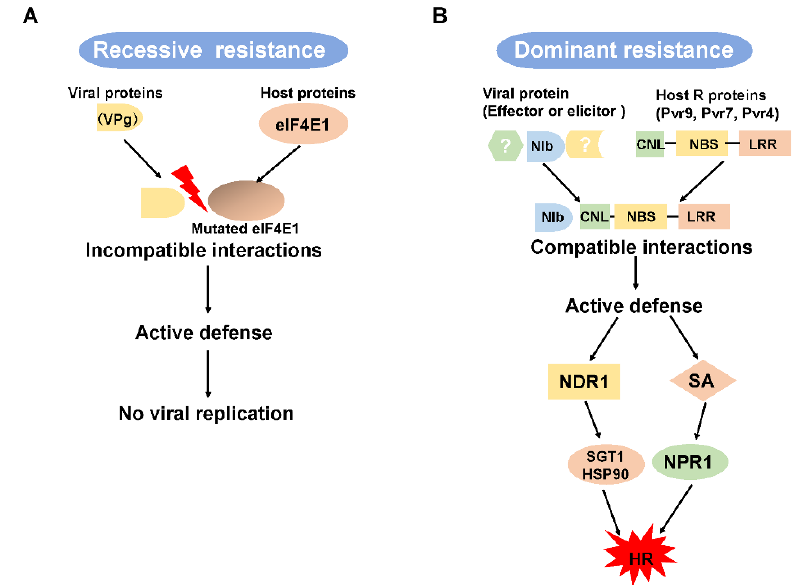
Figure 2. A scheme of host genes that may mediate recessive and dominant resistance and an explanation of the R protein-mediated signaling pathway. ( A ) Recessive resistance results from a host factor, the loss or mutation of which causes an incompatible interaction between a viral protein and a host protein. ( B ) Dominant resistance results from a compatible interaction between a viral effector and plant R proteins. Pvr9-mediated hypersensitive response requires several proteins, like NDR1 and the SGT1-HSP90 complex. Pvr9-mediated HR might also involve the SA pathway. NBS, nucleotide-binding site; LRR, leucine-rich repeat; CC, coiled-coil motif; HR, hypersensitive response; SA, salicylic